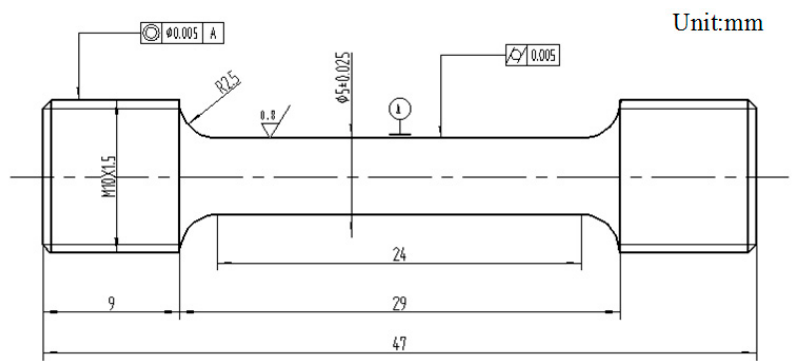
Figure 1. High-temperature tensile test specimen size of the Ti–45Al–9Nb alloy.